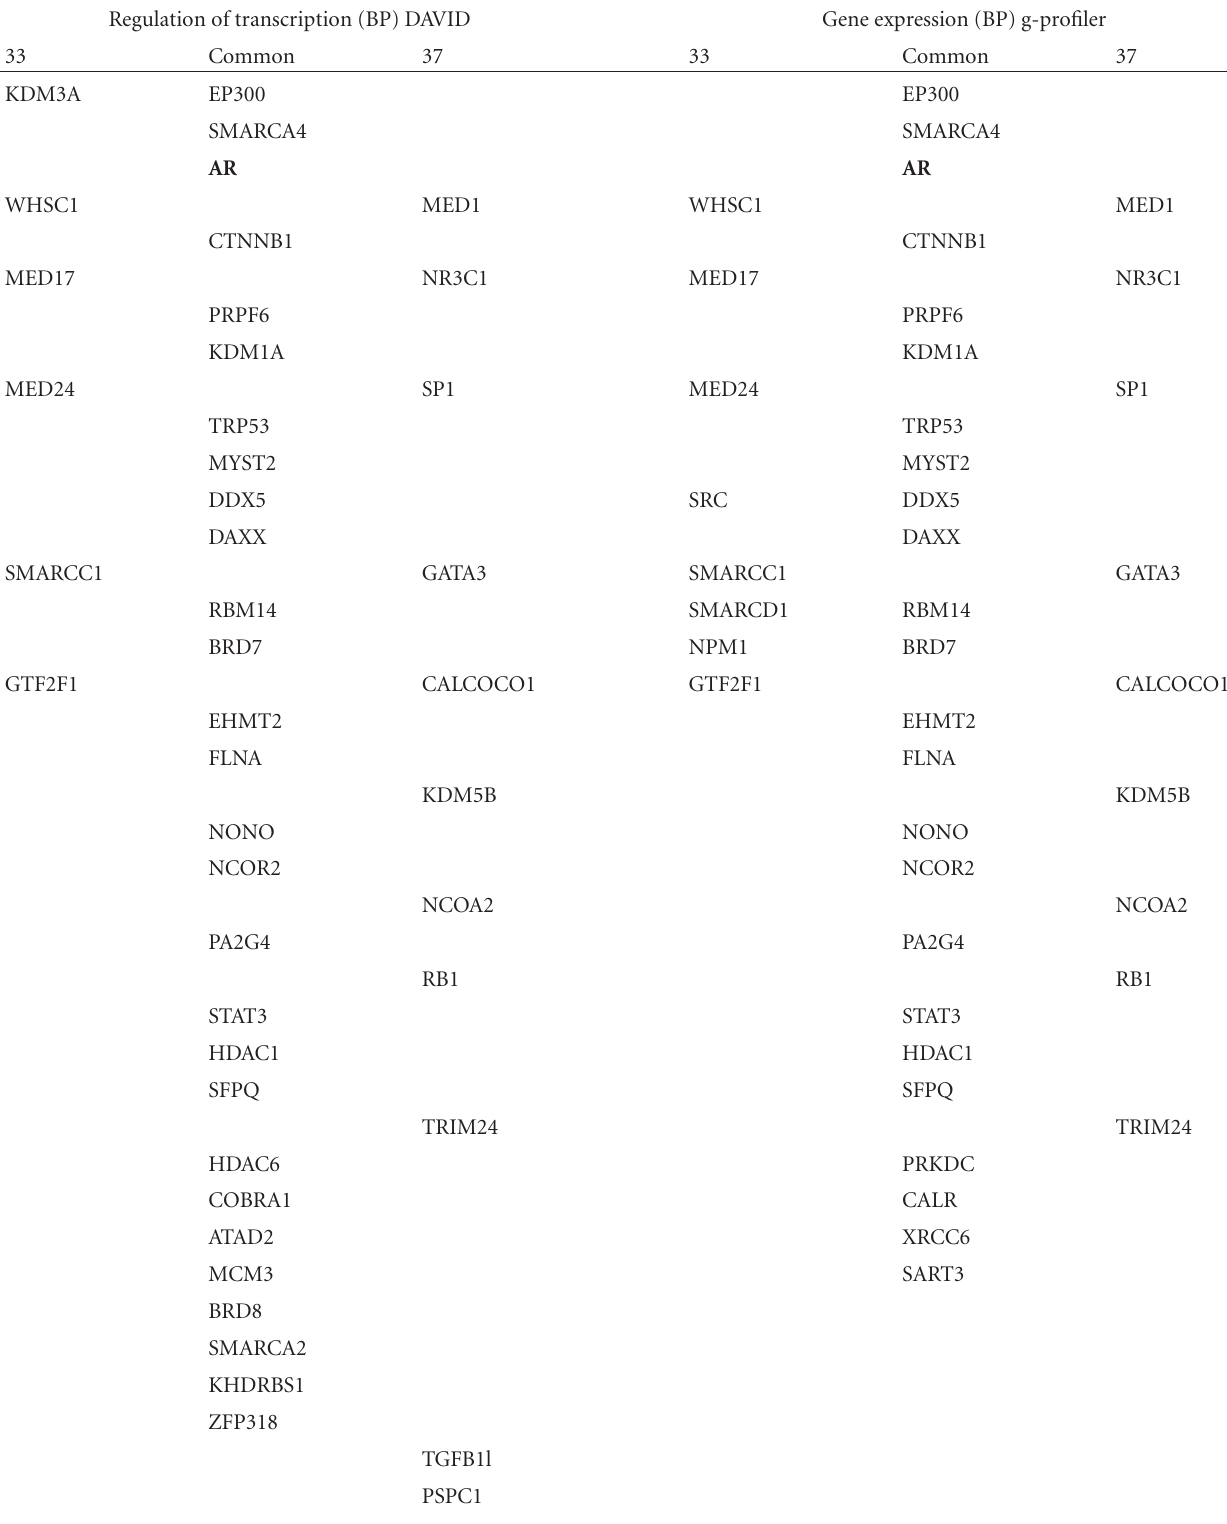
Table 2: Gene lists representing the biological processes (BP) “regulation of transcription” and “gene expression” identified by the bioinformatics tools “DAVID” and “g-profiler” as being overrepresented among the known AR-interacting proteins of the N-TAP-mAR purification. Listed are the interacting proteins, the AR is in bold face, that were unique for the proliferating cells (33), interacting proteins that were unique for the nonproliferating cells (37), and interacting proteins common to both